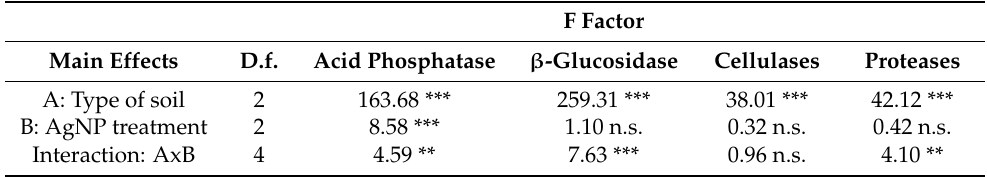
Table 2. Results from the Factorial ANOVA analysis (F values) for the soil exoenzymes activities. Factor